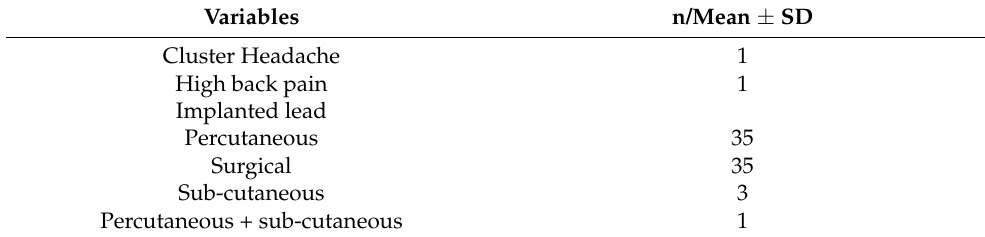
Table 1. Cont. Variables n/Mean ± SD Cluster Headache 1 High back pain 1 Implanted lead Percutaneous 35 Surgical 35 Sub-cutaneous 3 Percutaneous + sub-cutaneous 1 CRPS: Complex Regional Pain Syndrome; PSPS-T2: Persistent Spinal Pain Syndrome after